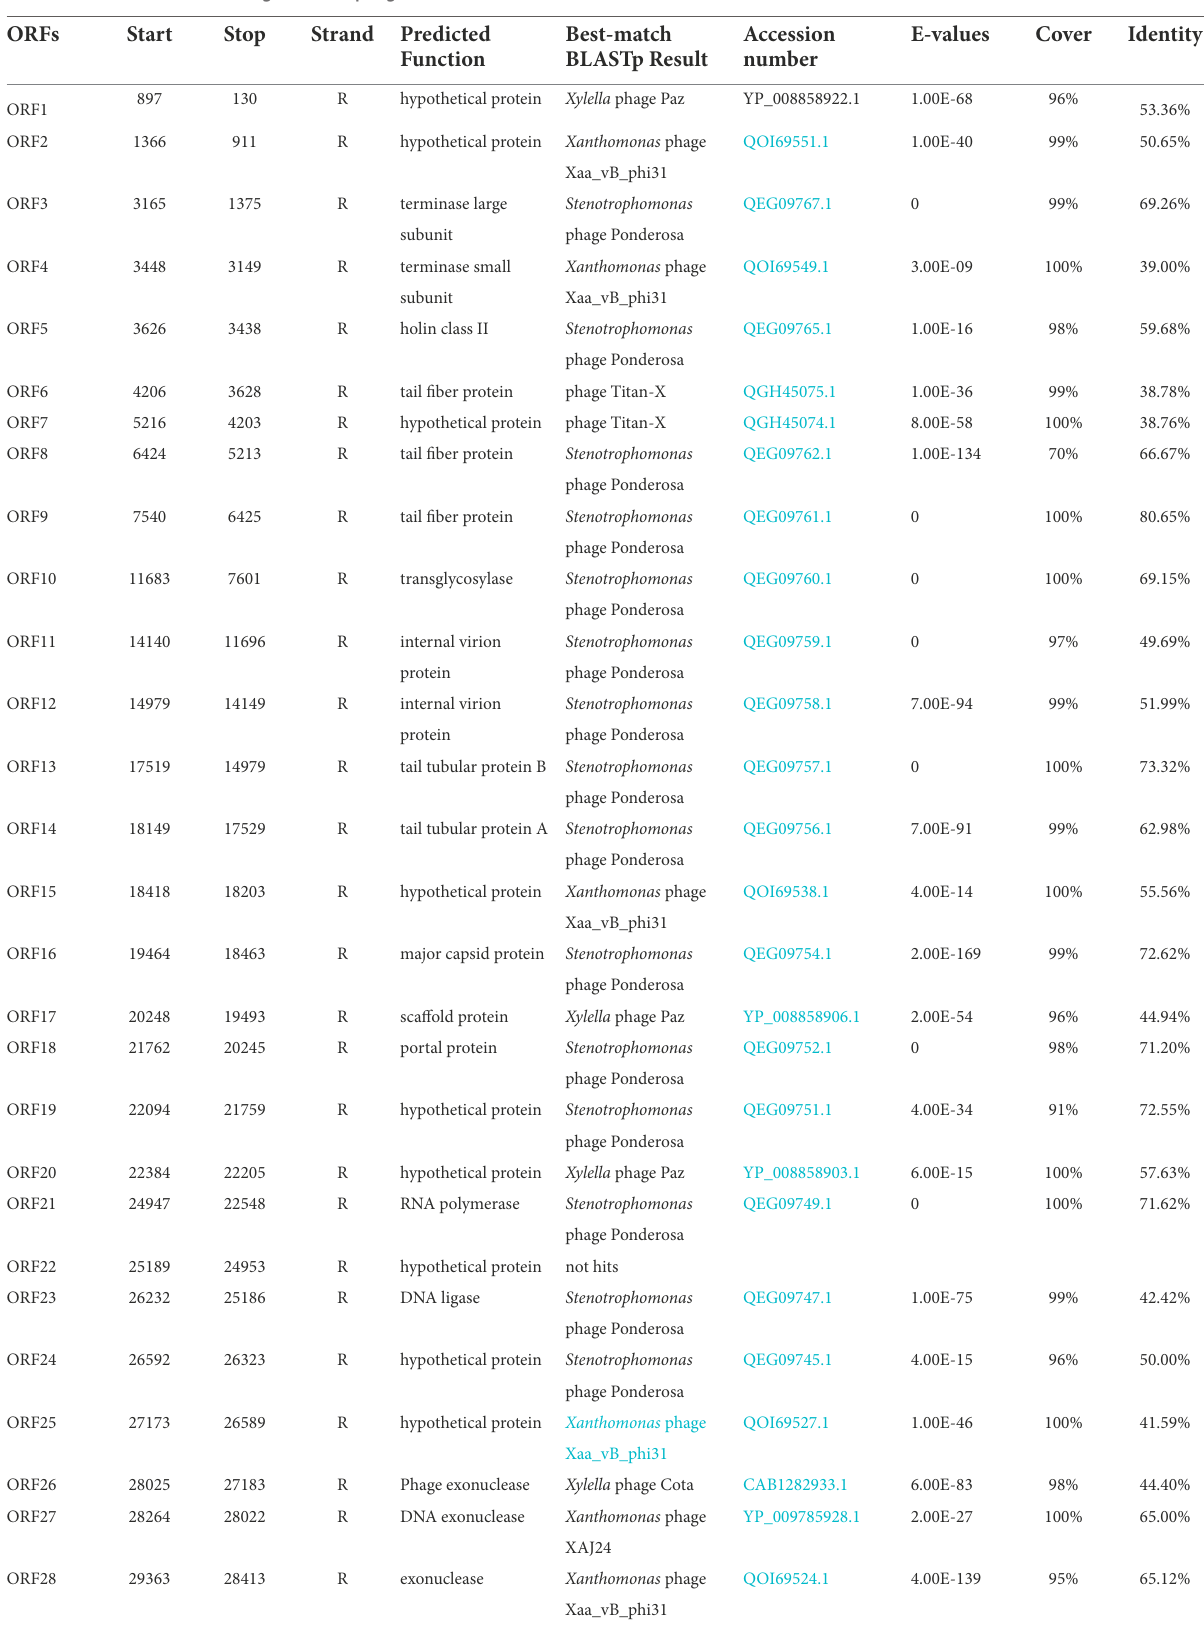
TABLE 1 Predicted ORFs in the genome of phage